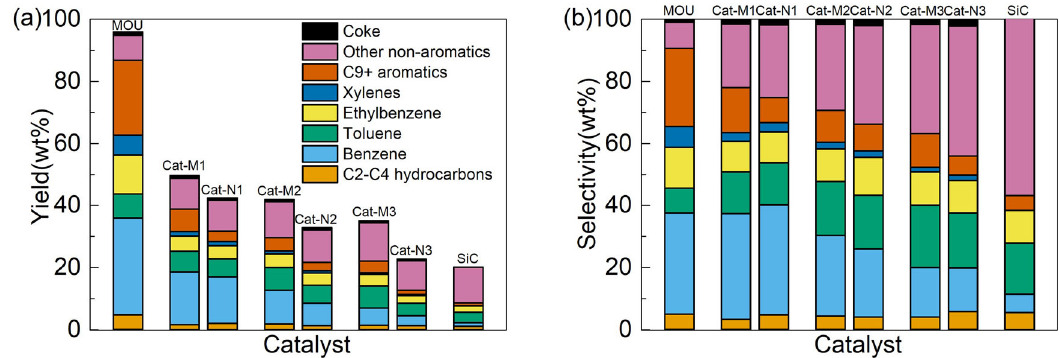
Fig. 2 Product distribution of n -butylbenzene reactions over catalysts with different reaction cycles. a Yield, b selectivity. The unconverted n - butylbenzene has been excluded from the